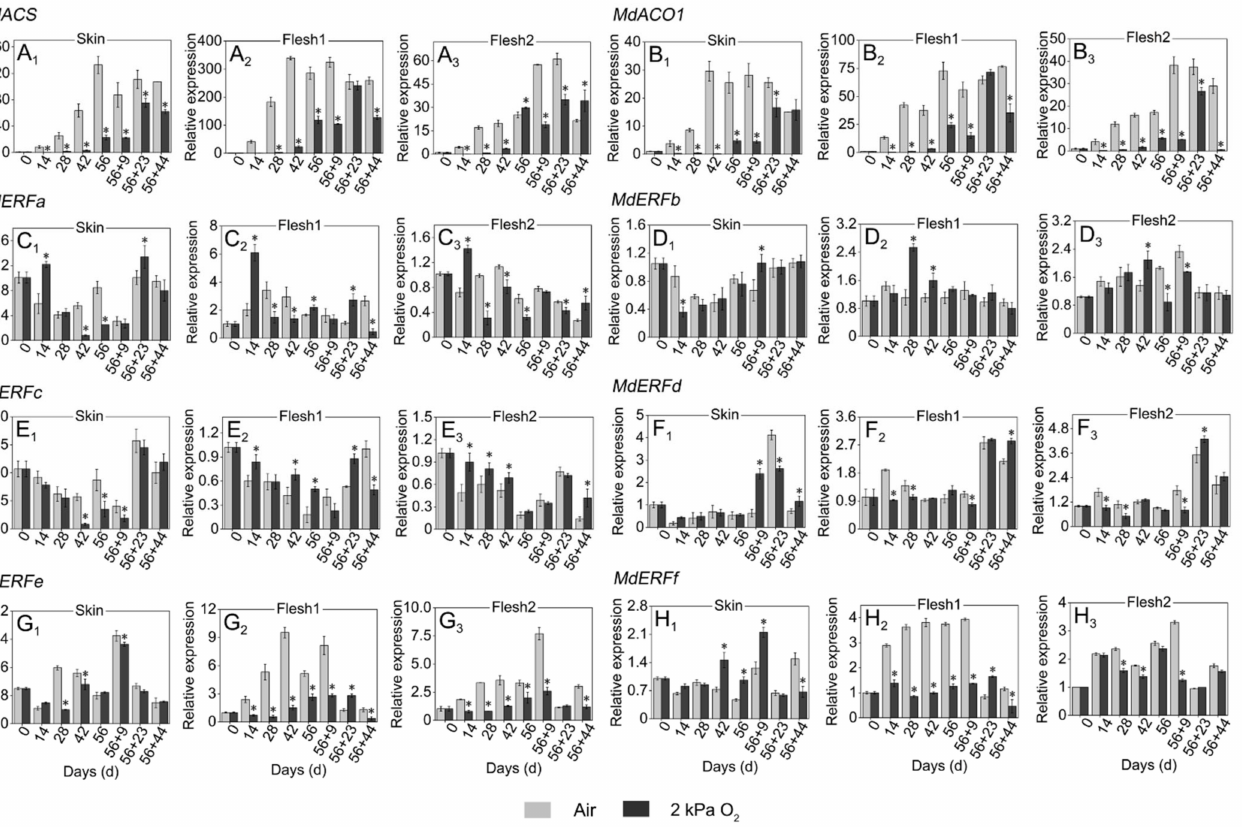
Figure 5. Expressions of MdACS , MdACO1, and MdERFs in skin and flesh of ‘Golden Delicious’ apple fruit during 56-day storage under 2 kPa O 2 + 98 kPa N 2 at 4 ◦ C and subsequent 44-day shelf life at 20 ◦ C. The expressions of MdACS , MdACO1 , MdERFa , MdERFb , MdERFc , MdERFd , MdERFe and MdEFRf are shown in ( A 1 – A 3 , B 1 – B 3 , C 1 – C 3 , D 1 – D 3 , E 1 – E 3 , F 1 – F 3 , G 1 – G 3 and H 1 – H 3 ),